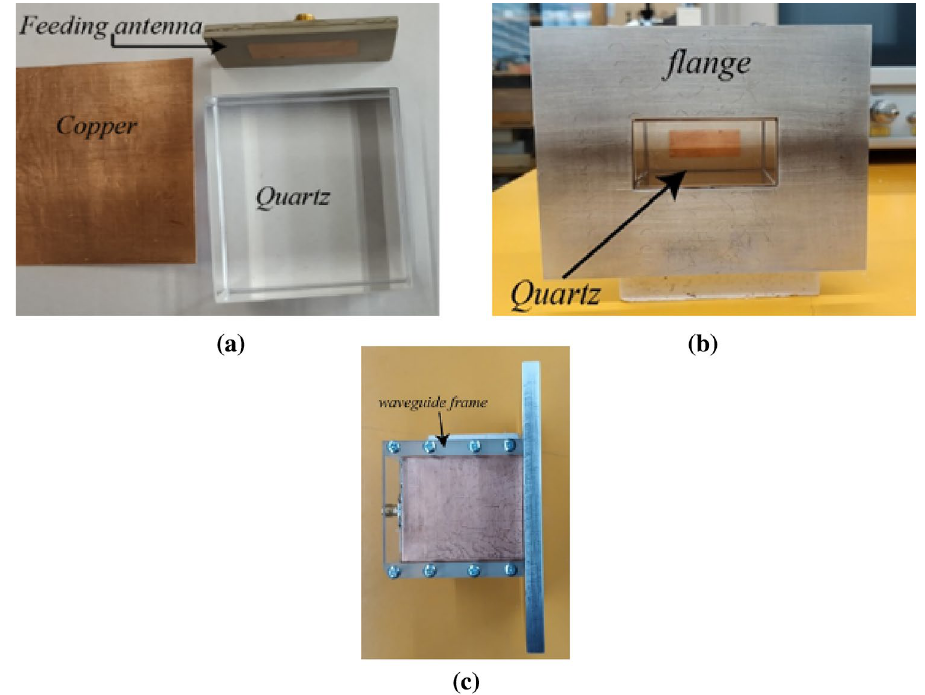
Figure 14. Fabrication of the waveguide prototype: ( a ) before assembly, ( b ) after assembly, ( c ) side view.